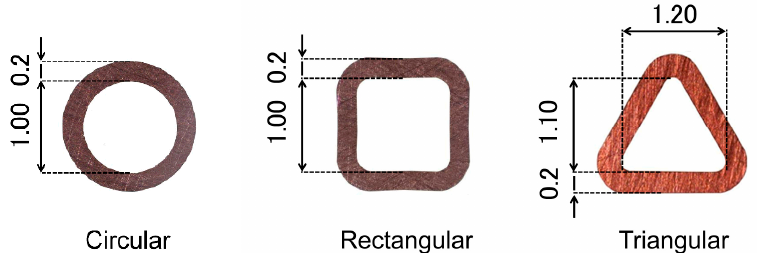
Figure 2. Test section for upward flow.